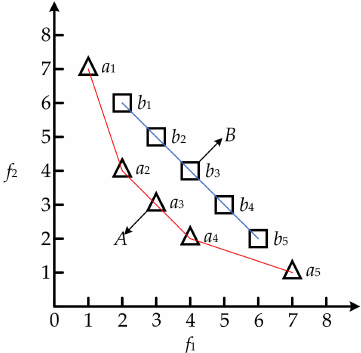
Figure 19. An example of calculating the convergence and spacing